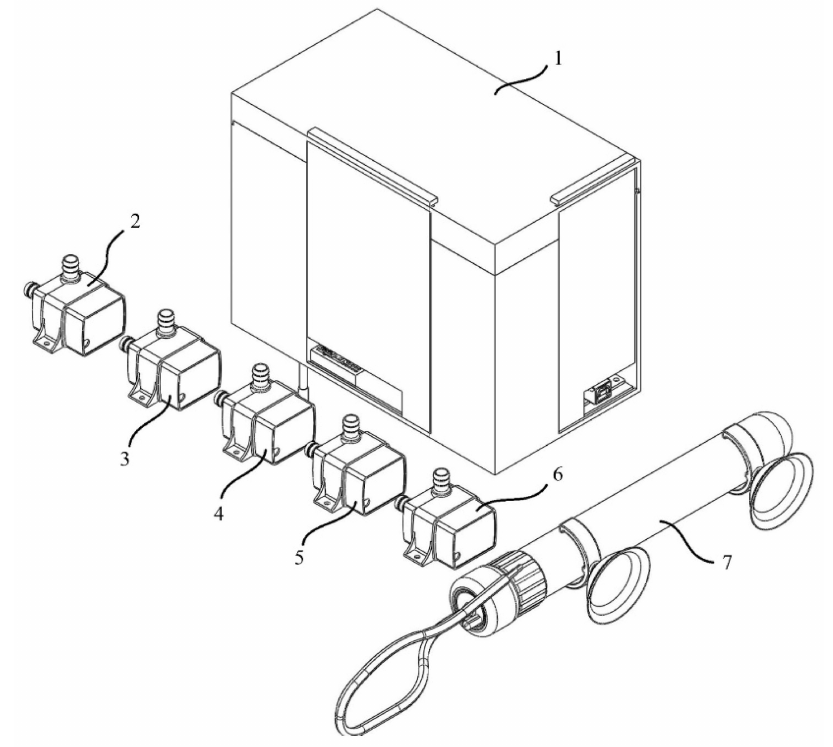
Figure 1. Images of the kit designed with the help of solid modeling software. Box design (1) the submersible pump used to control the dissolved oxygen amount (2), the submersible pump used to decrease the pH value (3), the submersible pump used to increase the pH value (4), the submersible pump used to reduce the EC value (5), another submersible pump (6), the heater